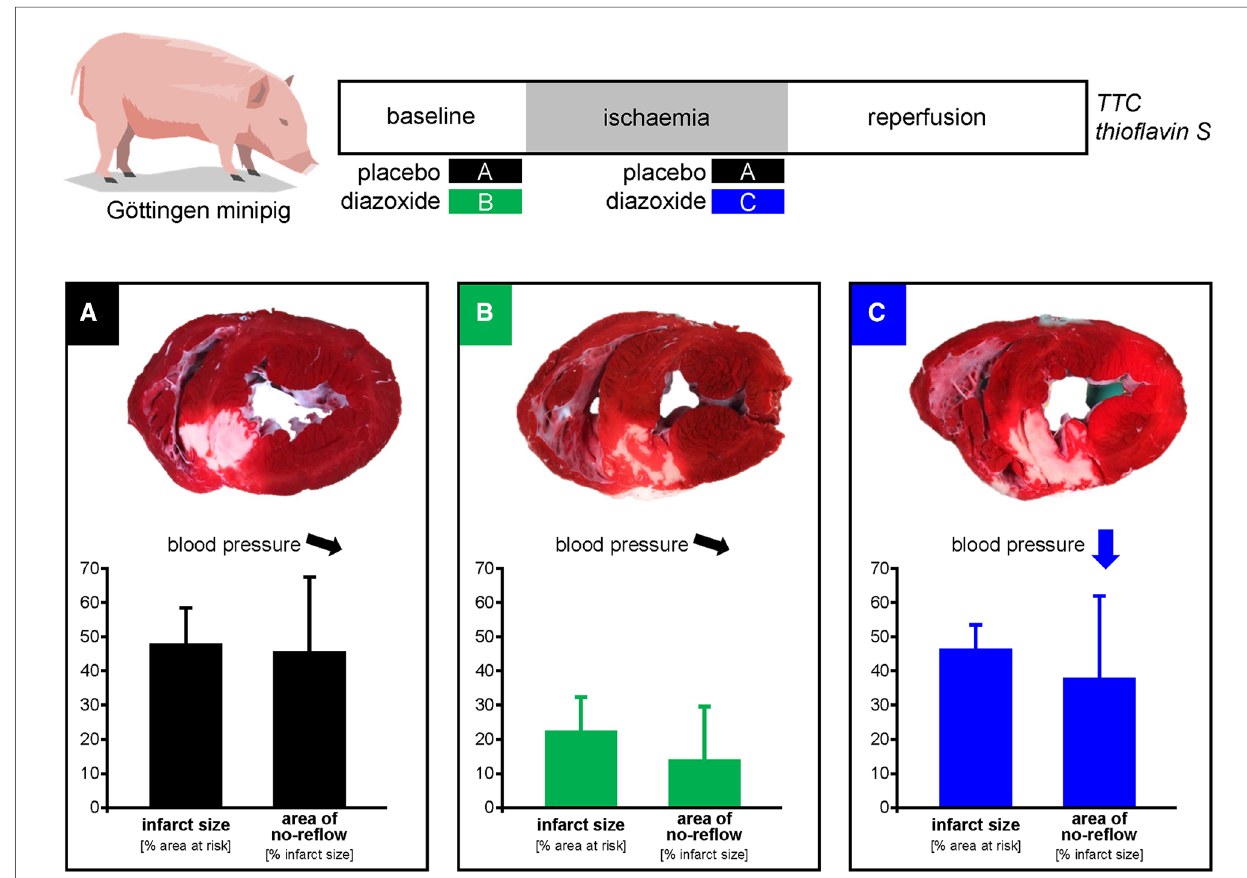
FIGURE 4 Schematic summary. Diazoxide activates mitochondrial ATP-dependent K-channels and stimulates respiration. Experiments in juvenile pigs had reported infarct size reduction by pretreatment with intravenous diazoxide. We now analysed the use of diazoxide in adult minipigs and in a more realistic scenario of administration before reperfusion. In comparison to placebo (A) , diazoxide pretreatment (B) reduced infarct size and area of no-re fl ow, but diazoxide before reperfusion (C) caused hypotension and did not reduce infarct size and no-re fl ow. Thus, cardioprotection with diazoxide is not feasible in a clinical scenario of acute myocardial infarction with administration before